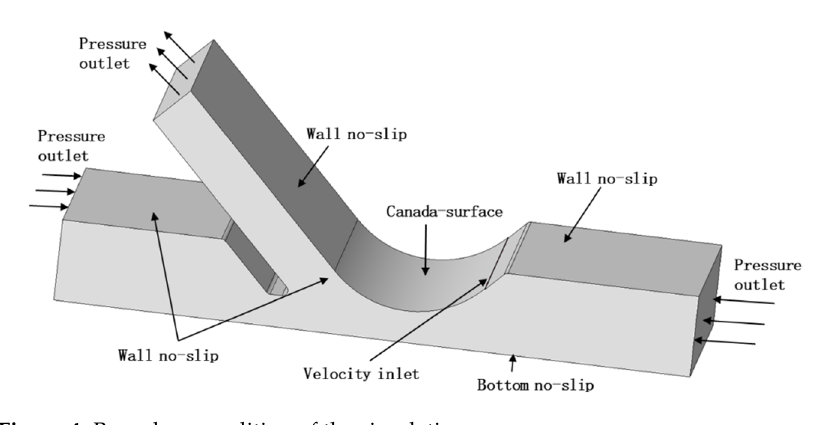
Figure 4. Boundary condition of the simulation.